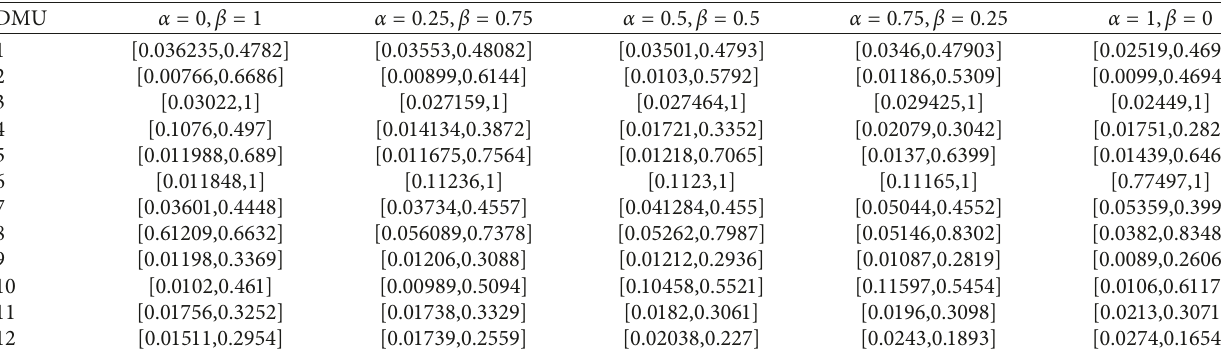
Table 6: Calculation of overall efficiency in the form of interval